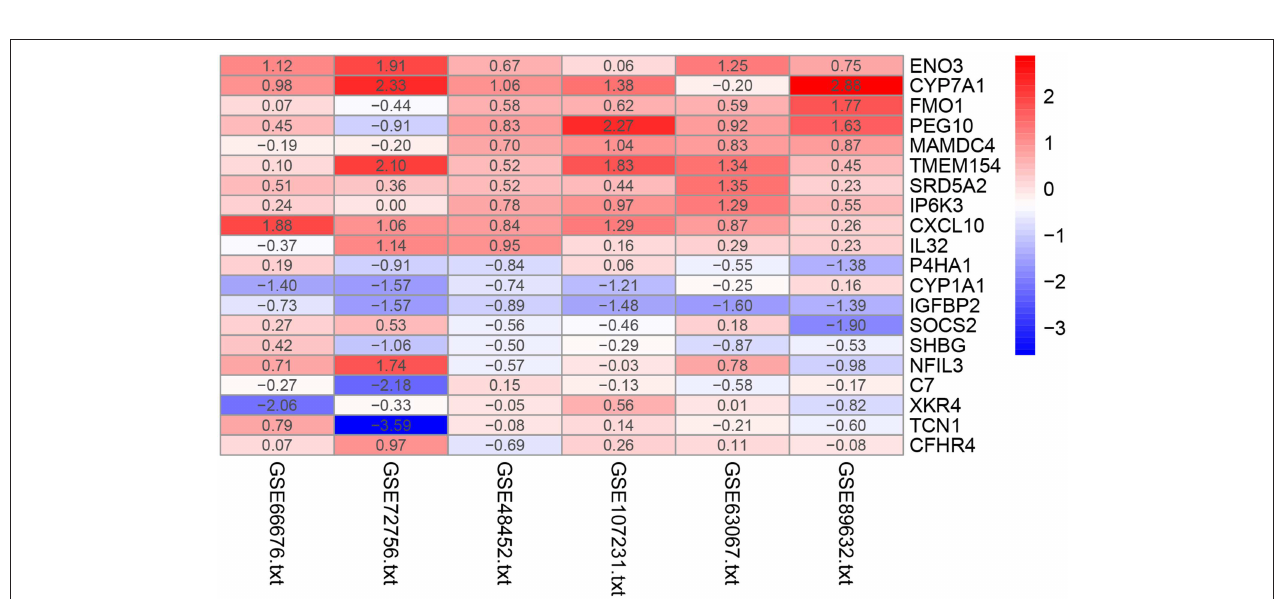
FIGURE 2 | Heatmap of the top 10 up- and down-regulated genes in the RRA analysis. Red represents high expression of genes in patients with NAFLD, while blue represents low expression of genes in patients with NAFLD. multi-gene host background determines disease phenotype and disease and to find potential treatments. However, there are progression (17). Therefore, identifying the susceptibility gene still no reports on the use of RRA method to detect DEGs in NAFLD. RRA algorithm, a well-designed tool, has four of NAFLD is very important for us to study the cause of this